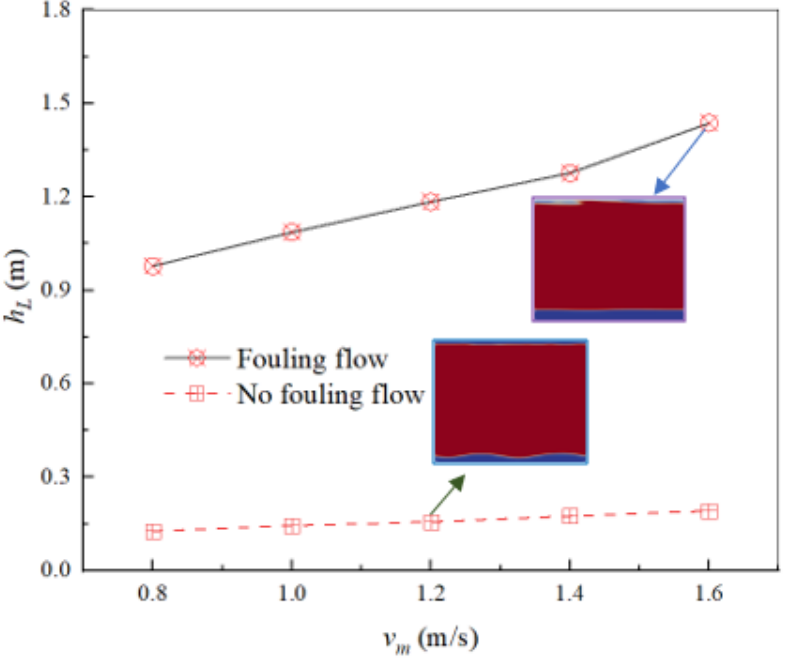
Figure 6. The effect of stability condition on head loss (the input pressure drop is 600–1500 Pa).